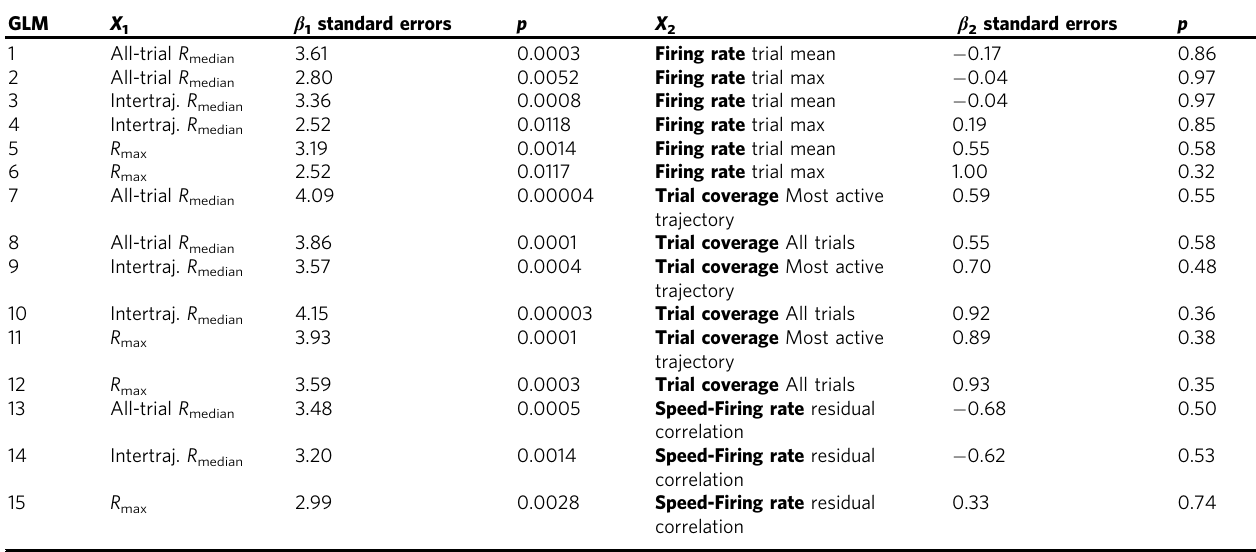
Table 1 Firing similarity measures predict participation in SWR